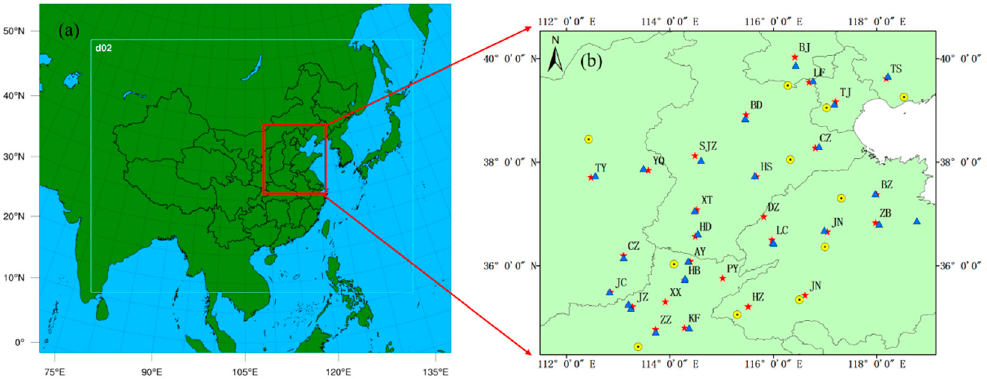
Figure 1. Model domain ( a ) and the spatial distribution ( b ) of the monitoring sites used in the model evaluation of the aerosols over North China Plain. The red dots indicate the component observation sites, the yellow dots indicate the PM 2.5 observation sites, and the blue dots indicate the meteorological observation sites.